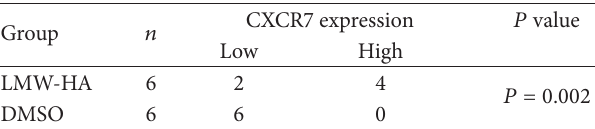
Table 2: CXCR7 expression in W3 cell transplanted tumor tissues of nude